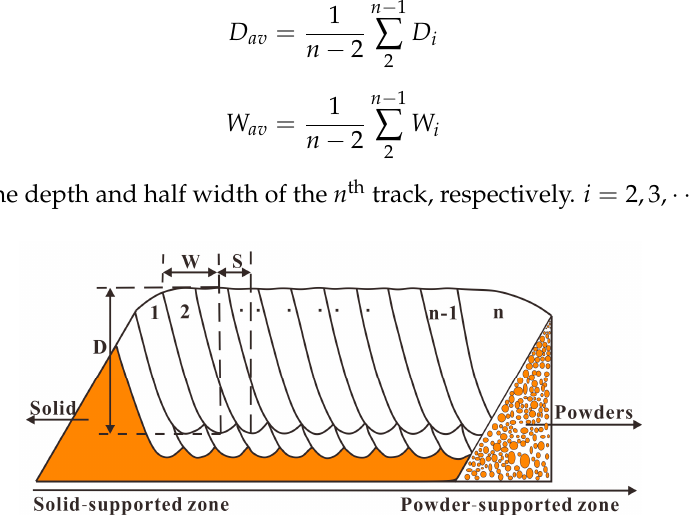
Table 3. Pixel size under specific magnification.